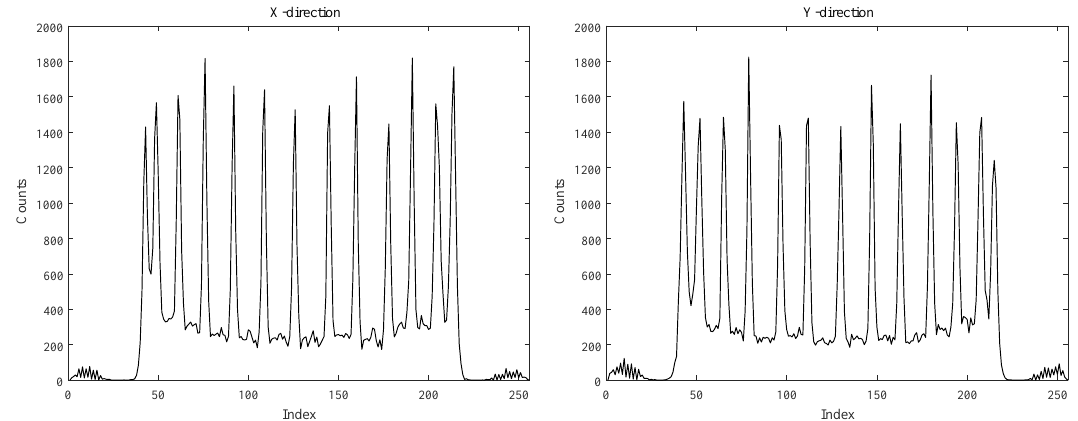
Figure 16. The projection profiles of the x direction and y direction of the flood histogram.